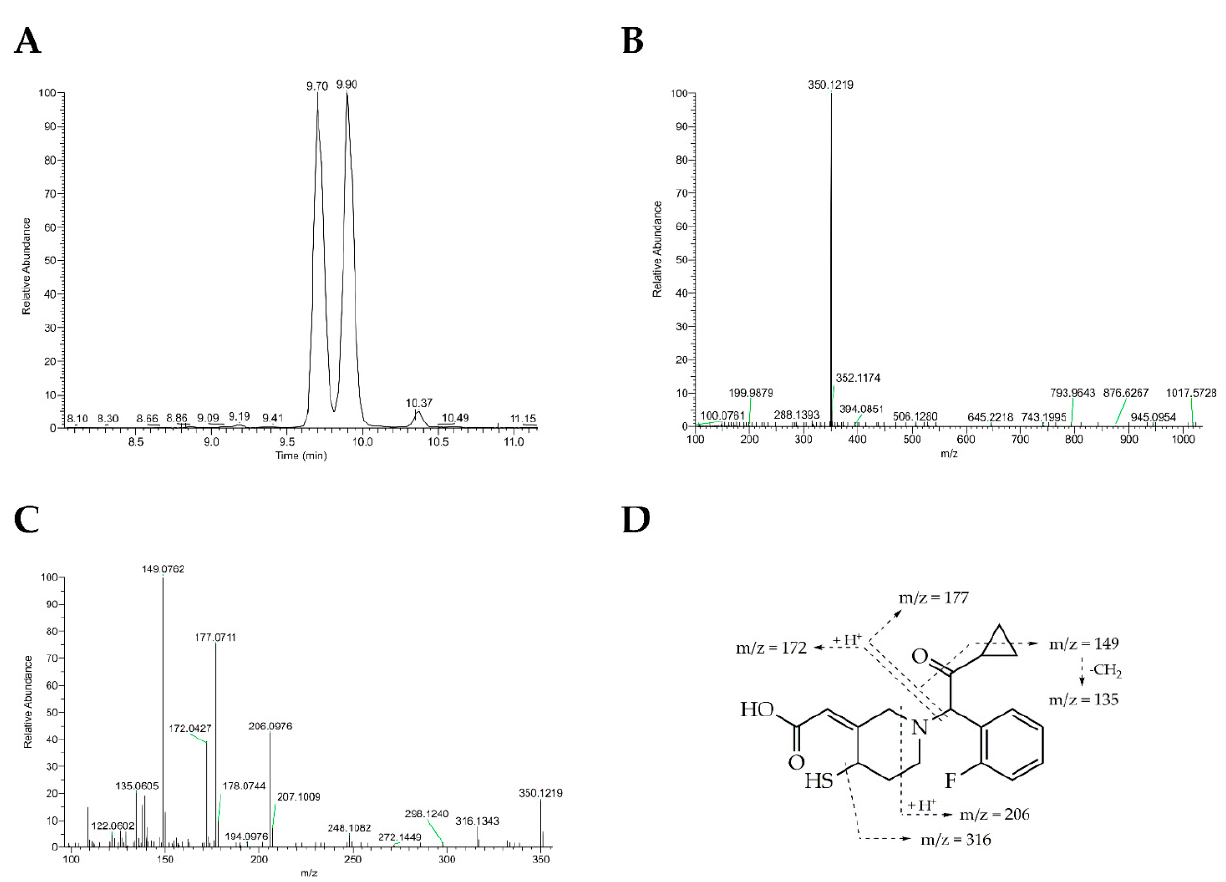
Figure 3. Extracted ion chromatogram and MS and MS 2 spectra of isomers of active prasugrel metabolite (PAM) formed during conversion of 1 mM prasugrel by 2 U mL − 1 PLE for 30 min followed by conversion with 2 U mL − 1 Mro UPO in the presence of 5 mM ascorbate, 20 mM KP i buffer (pH 7.0) and in sum 4 mM hydrogen peroxide. ( A ) Extracted ion chromatogram at m / z 350 (MS); ( B ) MS spectra of the two isomers; ( C ) MS 2 spectra of the ion at m / z 350 with collision energy of CE25; ( D ) assignment for the fragmentation pattern in ( C ).